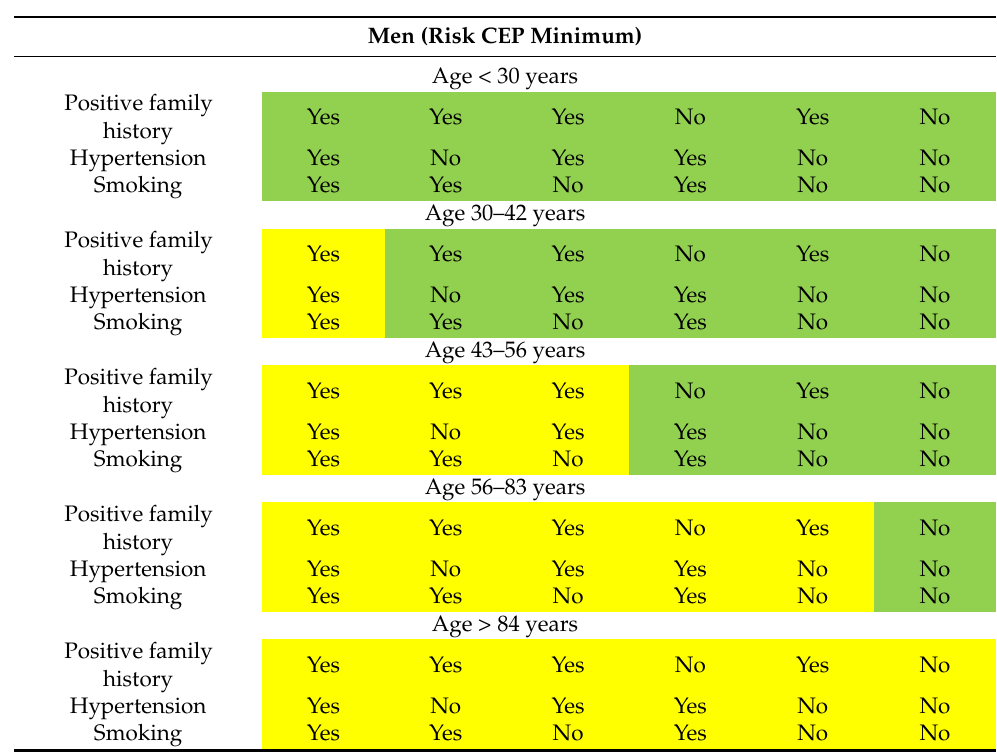
Figure 3. ROC curve in the prognostic model of CEP outcome in FH patients. Table 10. Scale for assessing the risk of CEP developing in men with defined and probable familial hypercholesterolemia (FH).